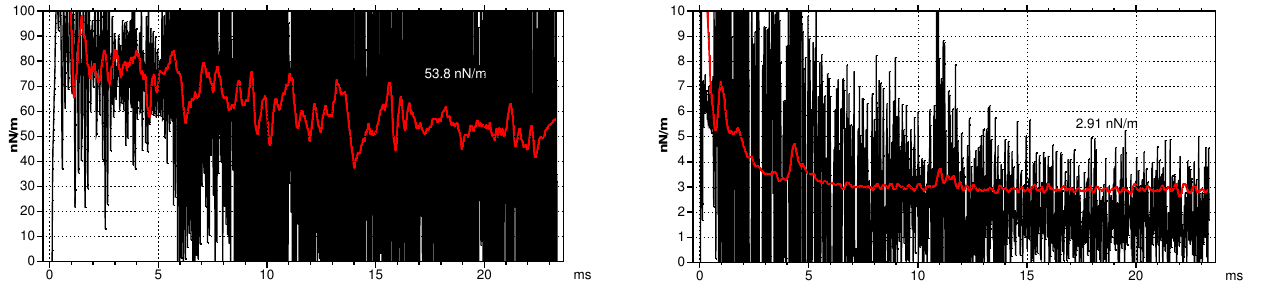
Figure 17. Run ProtonBzLong: proton plasma, B z = 30 000nT and 23.4ms